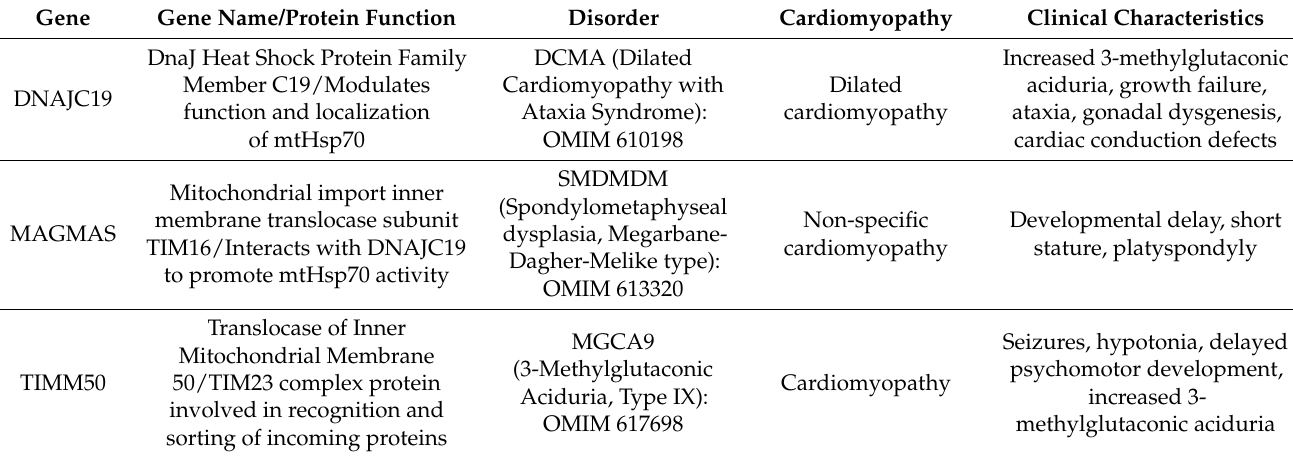
Table 1. Disorders presenting with cardiomyopathy that are involved in mitochondrial protein import into the inner mitochondrial membrane. Formal Online Mendelian Inheritance in Man (OMIM) report, protein function, and clinical characteristics are